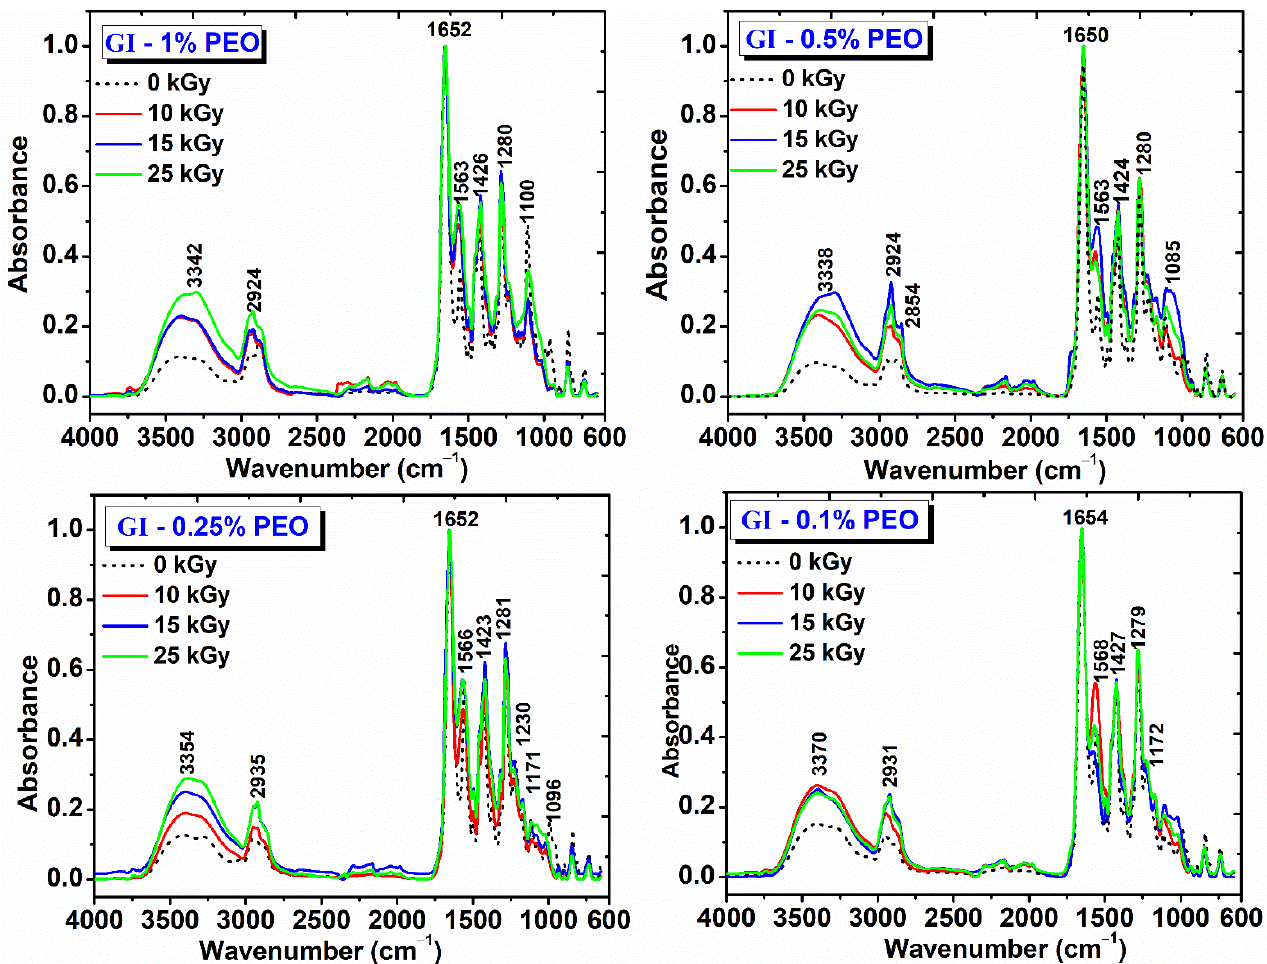
Figure 8. FTIR spectra for hydrogels prepared with (0.1–1)%